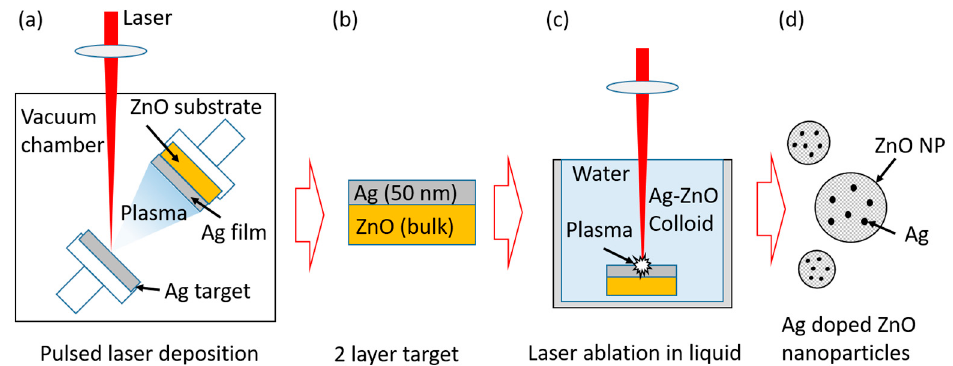
Figure 1. Experimental scheme for the synthesis of Ag-doped ZnO nanoparticles. ( a ) Pulsed laser deposition of Ag onto ZnO substrate (bulk), ( b ) two-layer target formed in PLD comprised of thin Ag film and ZnO bulk, ( c ) laser ablation of two-layer target in water and ( d ) Ag-doped ZnO nanoparticles synthesized in ( c ).